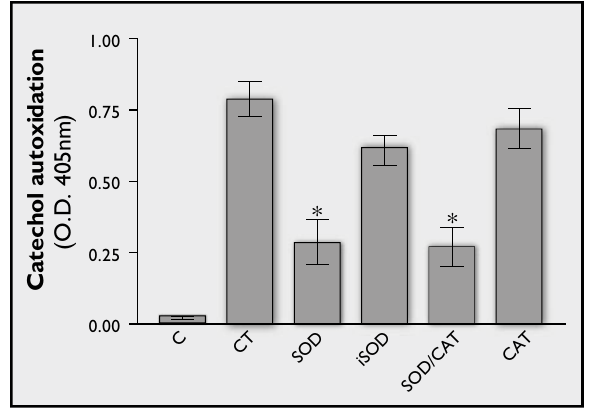
Figure 4 – SOD inhibits the formation of quinones in cultures of GL-15 cells. Cells were incubated for 72 hours with: 2 × 10 -5 M HCl (C); 300 µ M catechol alone (CT) or in the presence of 100U SOD (SOD), the same amount of heat-inactivated SOD (iSOD), 100U SOD combined with 500IU catalase (SOD/CAT) or 500IU catalase (CAT). Data are represented by the mean ± SD, n = 6; *p < 0.0001, when compared to cells treated with catechol alone